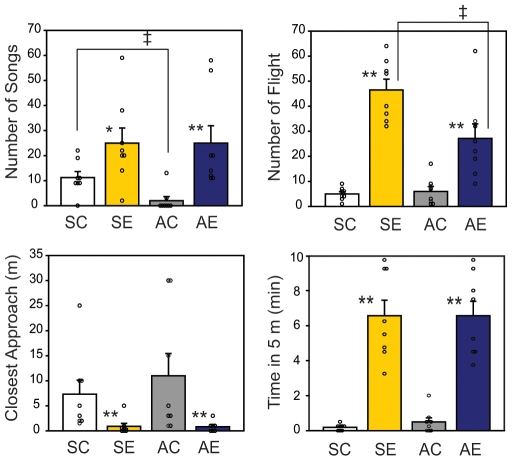
Aggressive behavior of sparrows subjected to simulated territorial intrusion during breeding and non-breeding season.Male song sparrows (n = 8/group) in their territory were exposed to a caged conspecific male decoy in addition to a recorded male song playbacks in breeding season, spring (SE) and non-breeding season, autumn (AE). As controls (AC, SC), a white-crowned sparrow decoy and recorded songs were used. Behavior of a subject was recorded for number of songs, number of flight, closest approach to the decoy (meters; m), and time spend within 5-m of the decoy. Kruskal-Wallis 1-way ANOVA followed by Mann-Whitney U test; significant at * p<0.05, ** p<0.01 between experimental conditions of the same season, or at † p<0.05 between seasons under same experimental conditions. Results are shown in mean±SEM.